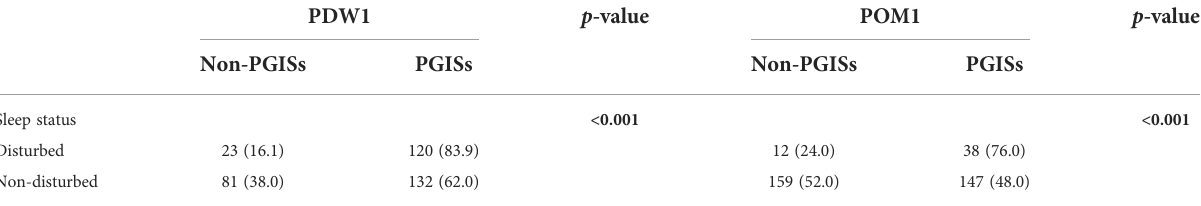
TABLE 3 The relations between PGISs and sleep